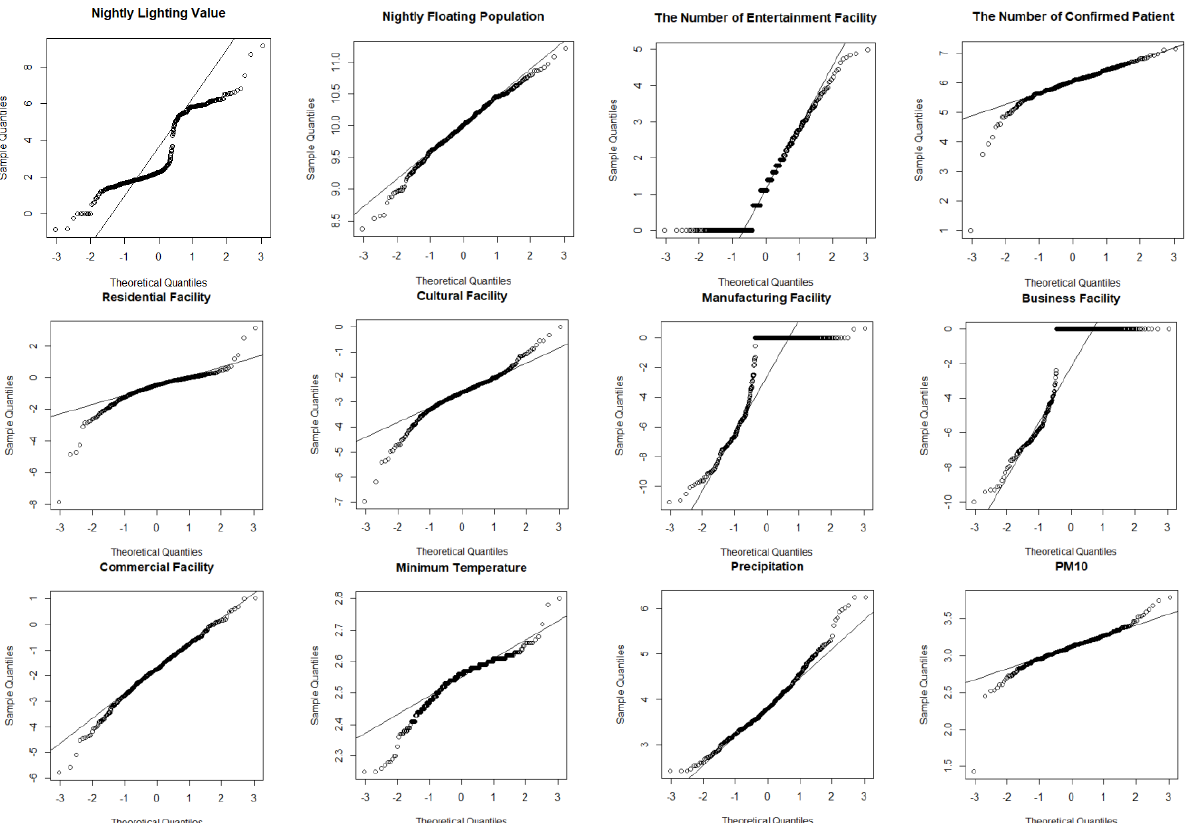
Figure A1. Q-Q Plot (Quantile-Quantile Plot) after log. Credit card sales 1 → restaurant and entertainment; credit card sales 2 → distribution; credit card sales 3 → food and beverage; credit card sales 4 → clothing and merchandise; sales 5 → credit card sales 5 → sports, culture and leisure; credit